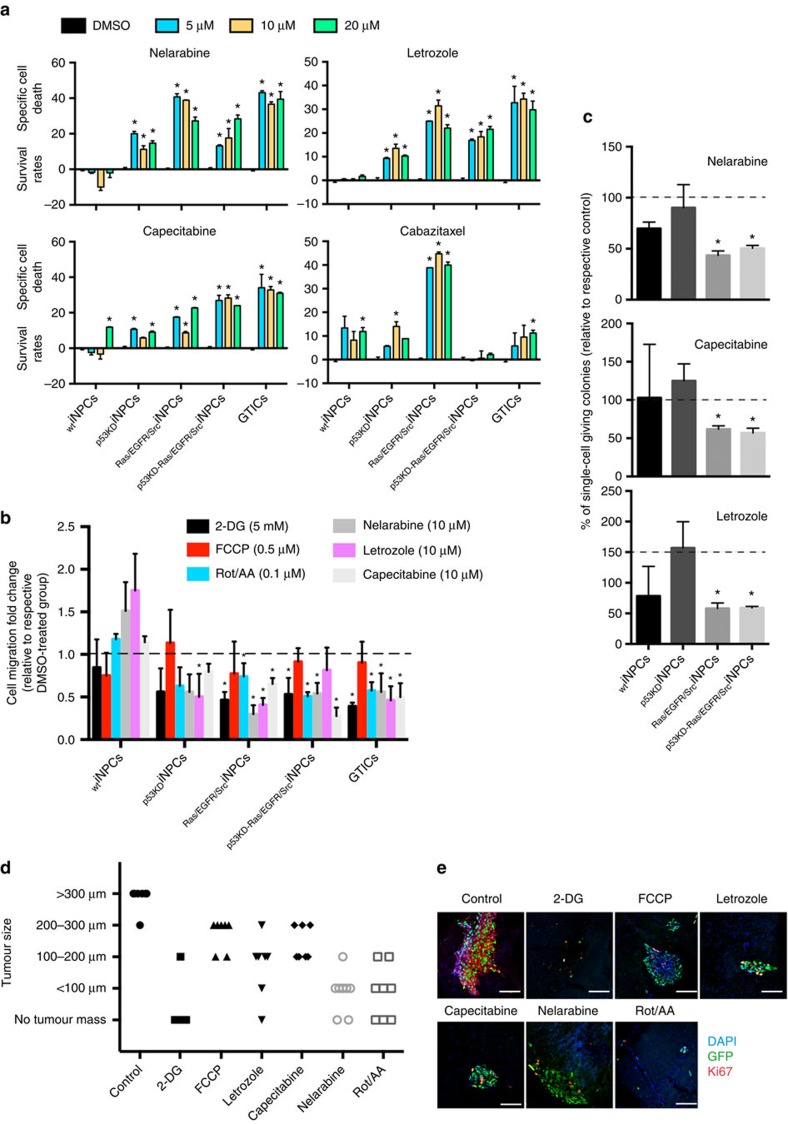
Anti-cancer compound screening identifies chemicals specifically targeting transformed iNPCs and primary GTICs.(a) Annexin V staining, as measured by flow cytometry, validates the role of lead compounds at the indicated concentrations and demonstrates a specific effect against primary GTICs and transformed iNPCs for three of the compounds analysed (Nelarabine, Letrozole and Capecitabine). In contrast, Cabazitaxel demonstrated group-dependent effects and targeting of WTiNPCs. Data are presented as a ratio to the values obtained in the respective DMSO control groups. Negative values indicate increase viability in where basal Annexin V staining was higher in DMSO samples as compared with those treated with specific compounds; (n=3 group/condition with three technical replicates). (b,c) Treatment of transformed iNPCs and primary GTICs with the identified compounds and metabolic modulators compromises glioma stem cell properties including migration (b, n=3 group/condition with three technical replicates) and self-renewal potential in single-cell assays (c; n=3 group/condition with 24 technical replicates). (d) Tumour size measured on brain organotypic cultures for each indicated condition. Data are independently plotted for each organotypic brain slice analysed (n=>3 condition with technical triplicates). (e) Representative pictures of organotypic brain slices injected with primary GTICs and treated with each of the indicated compound. Brain slices were immunostained with the indicated markers as follows: DAPI (blue), GFP (green) and Ki67 (red). Data are represented as mean±s.d. P values were calculated by Student's t-test or Mann–Whitney test when appropriate. *P<0.05. Scale bars, 100 μm (e).